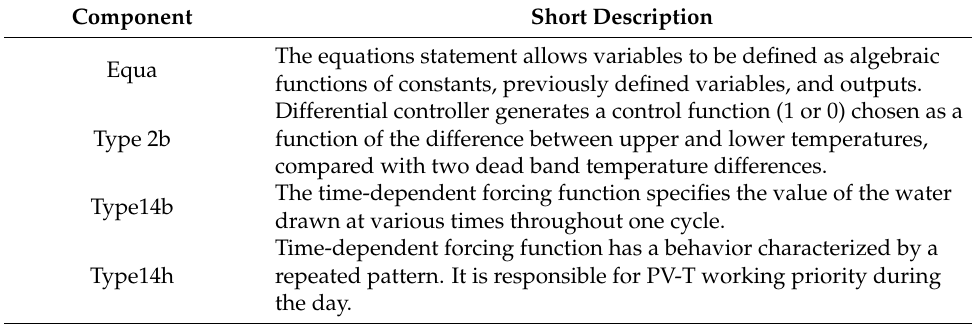
Table A1. Short description of the components used in transient models based on